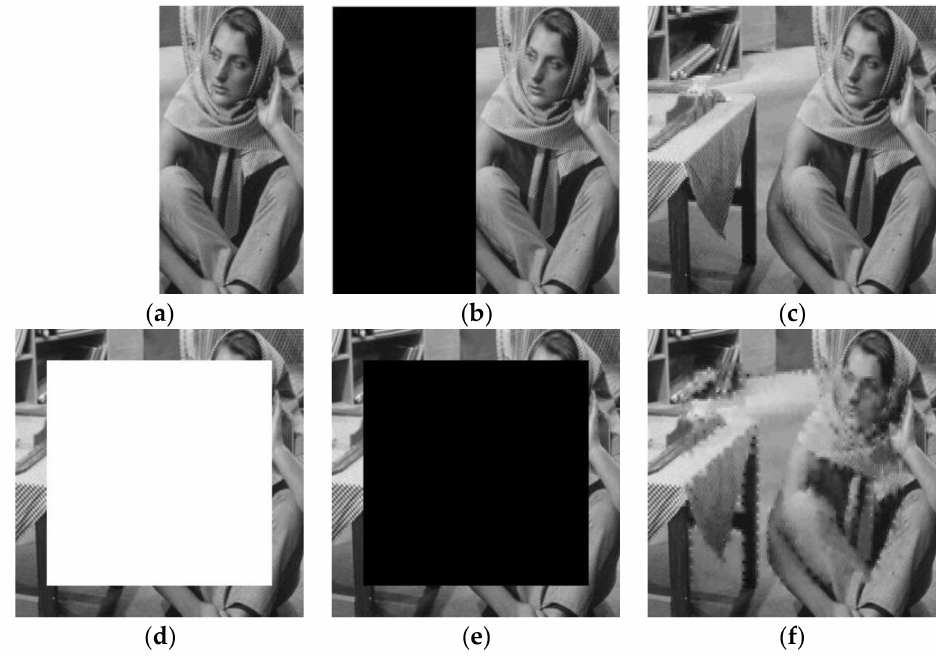
Figure 13. Large area tampering test: ( a ) Left 50%; ( b ) tamper detection result; ( c ) recovered image (PSNR = 32.05 dB); ( d ) middle 80%; ( e ) tamper detection result; ( f ) recovered image (PSNR = 19.69